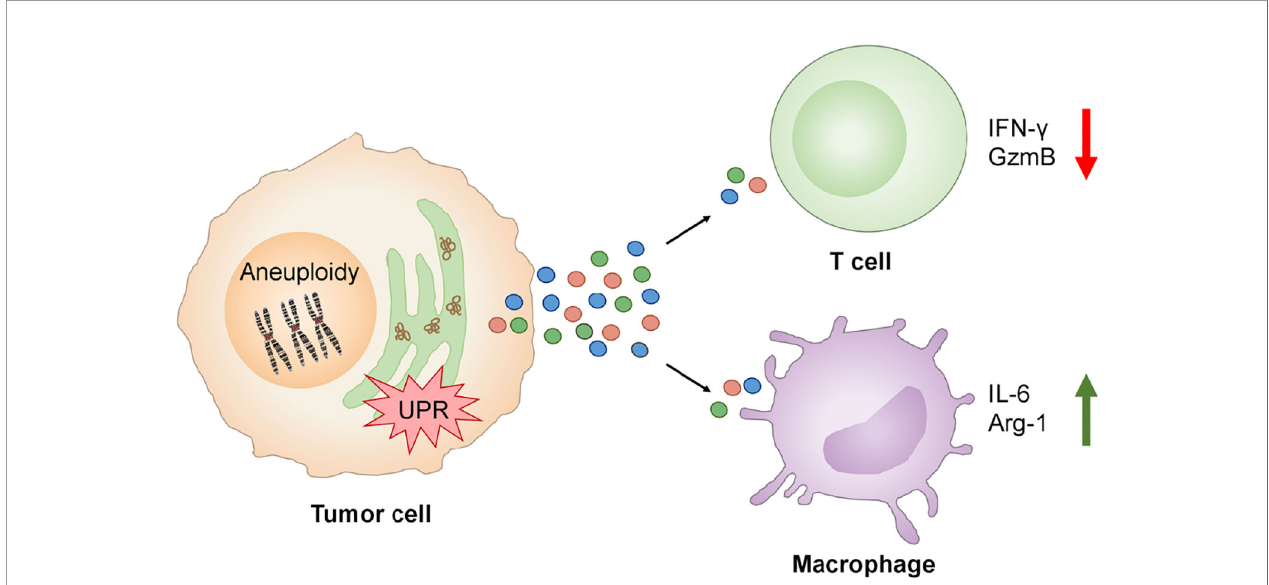
FIGURE 5 | UPR links aneuploidy to immune cell dysregulation in the tumor immune microenvironment. Aneuploidy and UPR activation in tumor cells induces the secretion of factors which inhibit the production of IFN- g and Granzyme B by activated T cells and promotes expression of IL-6 and Arg-1 by macrophages contributing to local pro-in fl ammation and immune